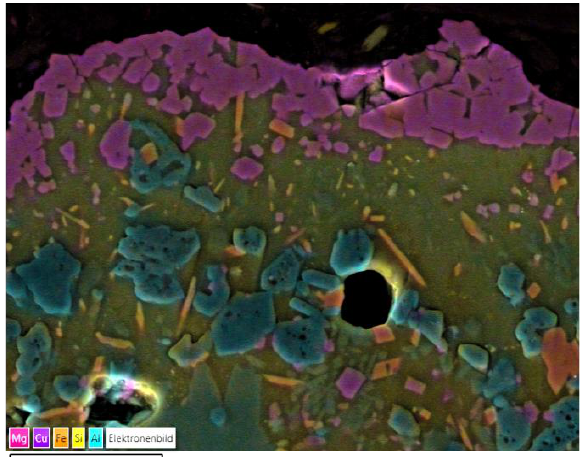
Figure 6. SEM/EDS Mapping of black spinel coated bauxite proppant BL 1630 after thermal aging.